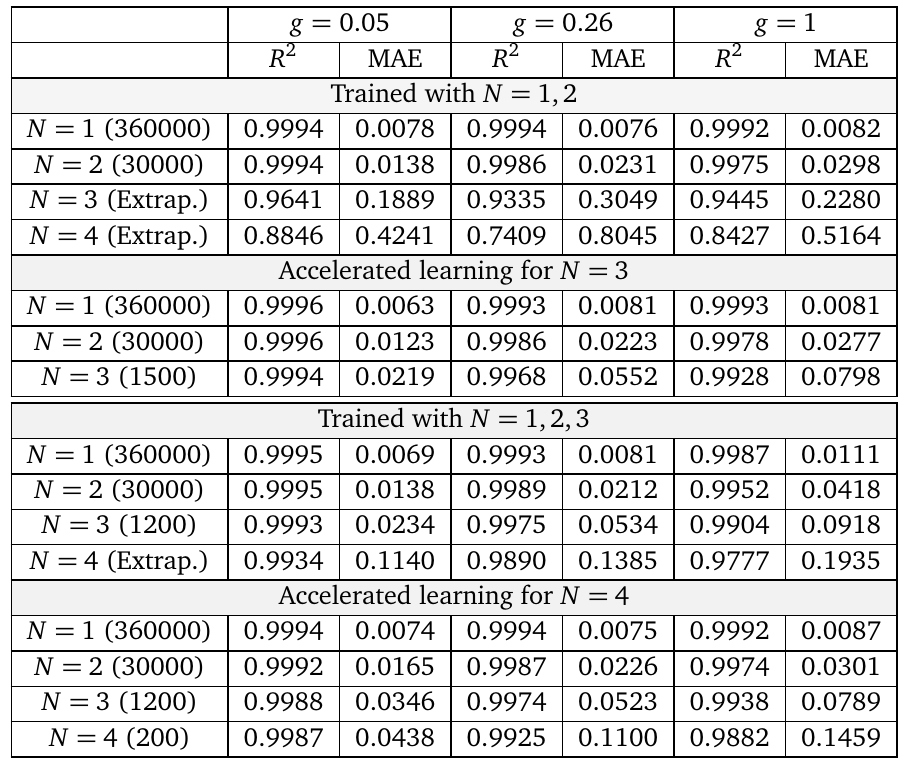
Table 3: Performance of the neural network in the real-case scenario. The coeffi- cient of determination R 2 and the mean absolute error MAE are reported for three interaction strengths g , considering networks trained on N = 1,2 and on N = 1,2,3. The test results are shown for the particle numbers N included in the training set (number of training instances in parenthesis), for the extrapolations to N = 3 and to N = 4, and for the accelerated